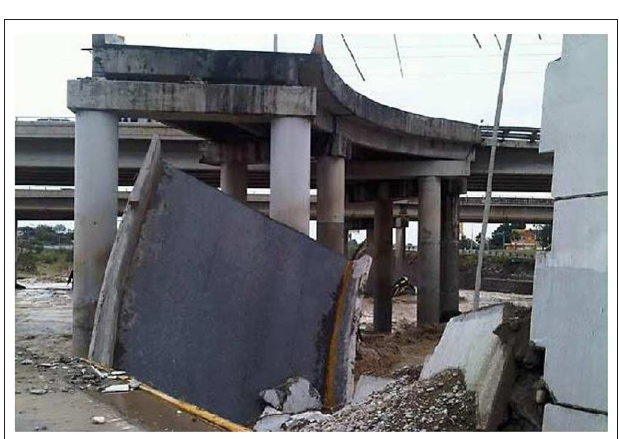
FIGURE 10 | Damages to Morones Prieto Avenue. Courtesy from El Norte.